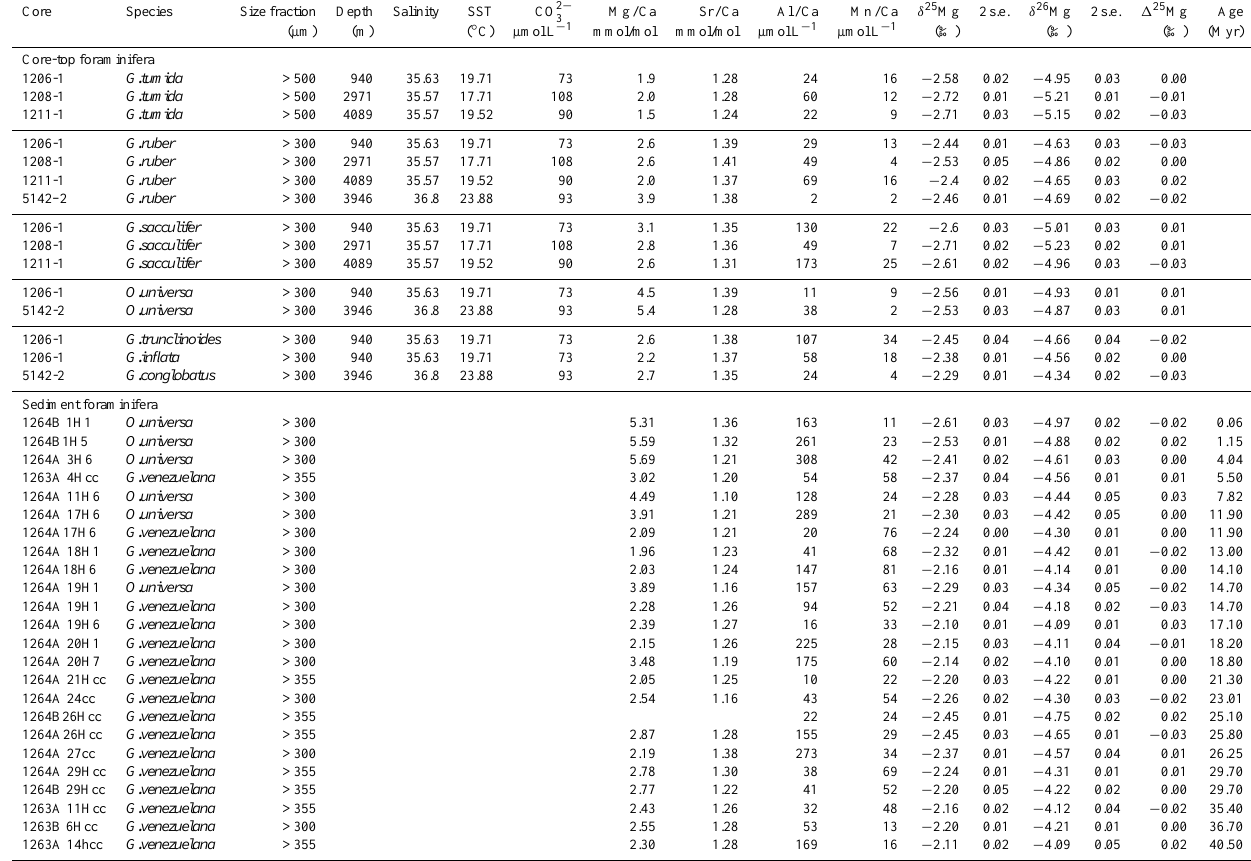
Table 1. Mg isotope compositions and data from both core-top and past foraminifera. Core Species Core-top foraminifera